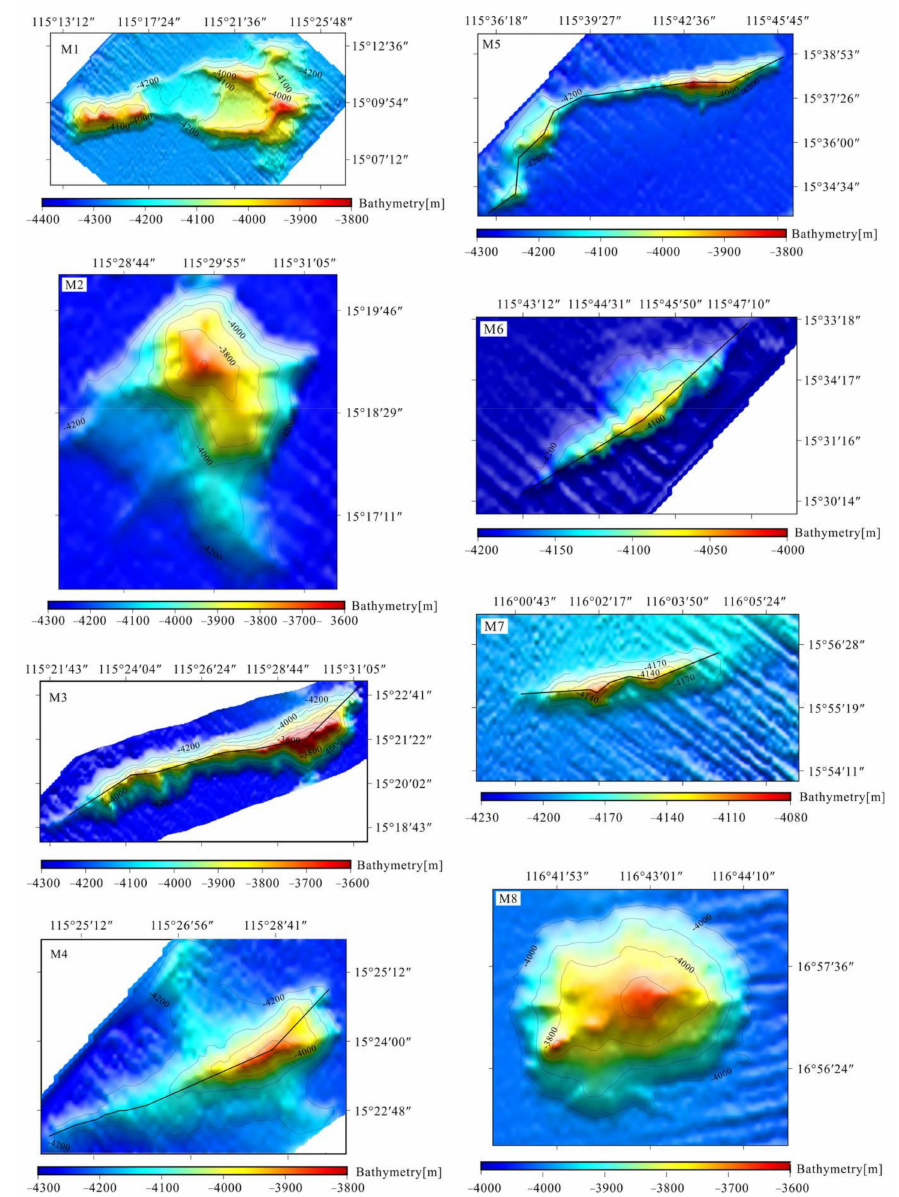
Figure 12. Multi-beam bathymetry map of the identified seamounts in the South China Sea basins. The three types of seamounts are interpreted as the conical, linear and irregular types. The ( M1 ) and ( M2 ) seamounts are the irregular type. The ( M3 – M7 ) seamounts are the linear type. The ( M8 ) seamount is the conical type. The black lines indicate the ridge lines of the seamounts. The detailed locations of the seamounts are shown in Figures 1 and